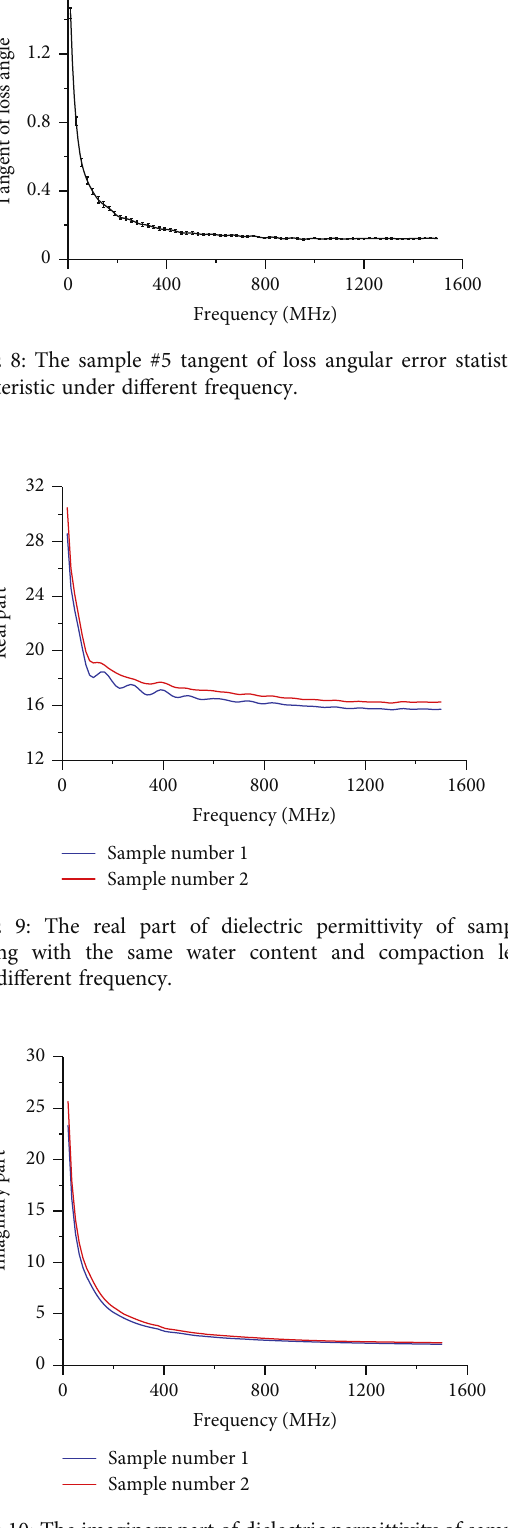
Figure 10: The imaginary part of dielectric permittivity of samples changing with the same water content and compaction level under di ff erent frequency.